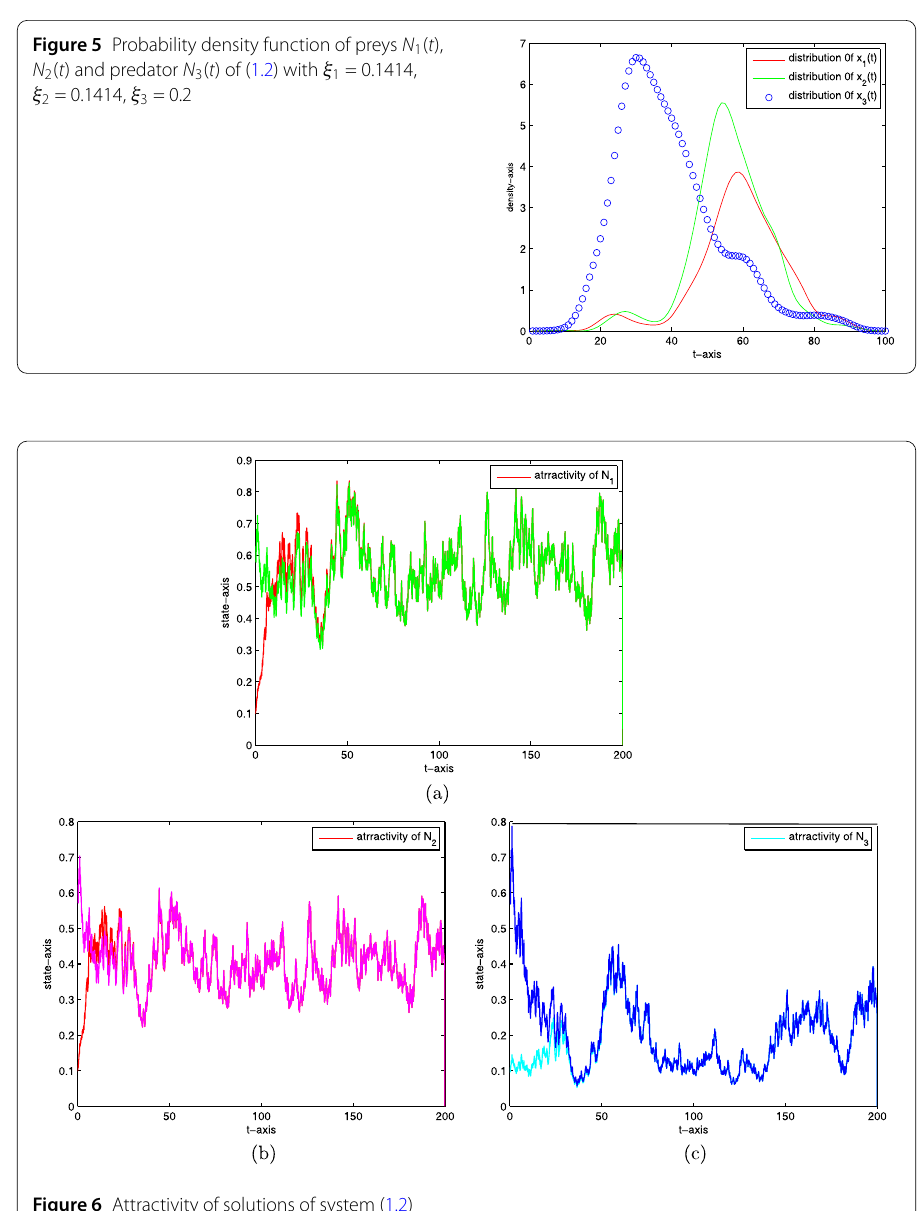
Figure 6 Attractivity of solutions of system (1.2)